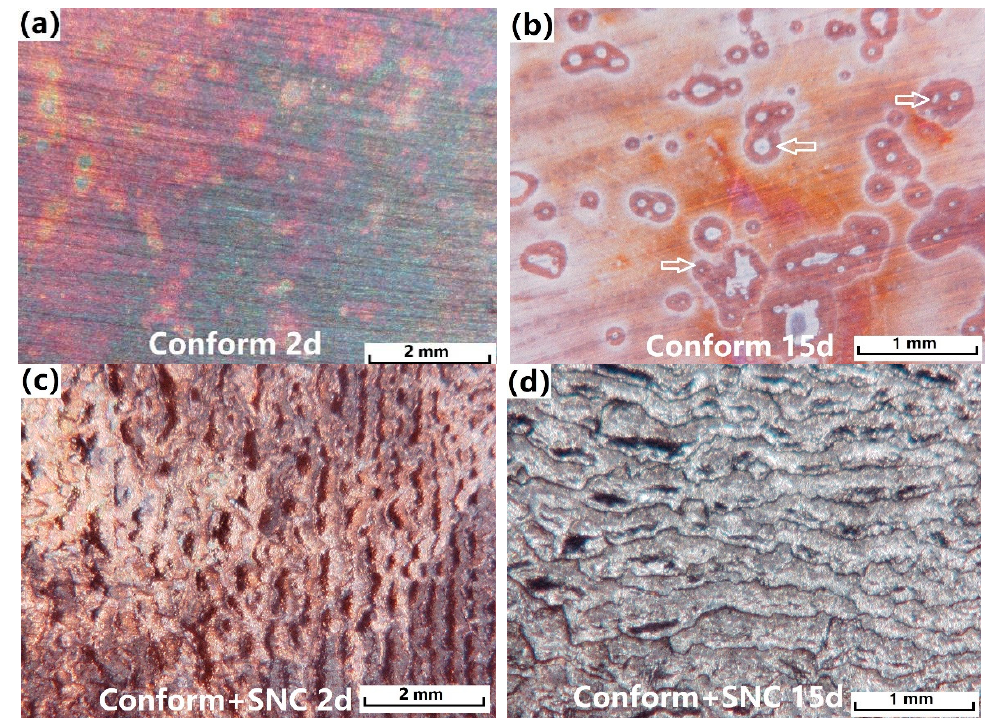
Figure 7 . Macro-appearance of the conform and conform + SNC Cu-Mg alloy immersed in 0.1 M NaCl solutions for 2 days and 15 days. ( a ) Conform sample after corrosion for 2 days; ( b ) Conform sample after corrosion for 15 days; ( c ) Conform + SNC sample after corrosion for 2 days; ( d ) Conform + SNC sample after corrosion for 15 days.